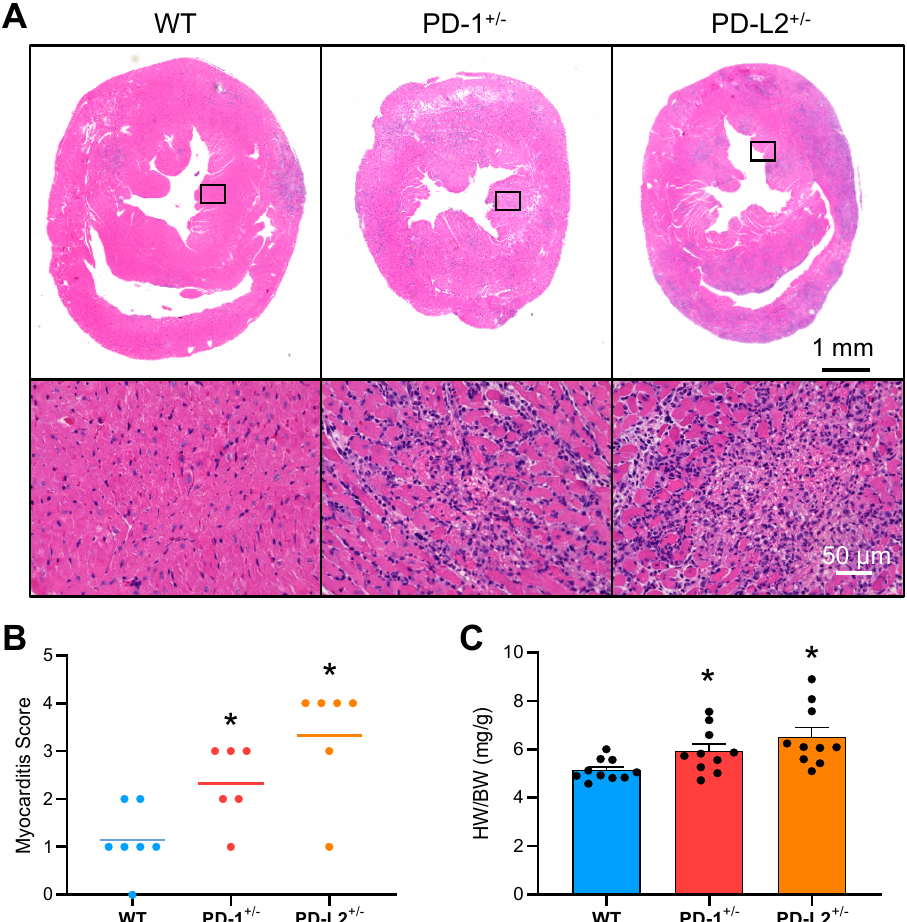
Figure 3. PD-L2 deficiency exacerbates myocardial inflammation in experimental autoimmune myocarditis. F1 hybrids of PD-1 − / − , PD-L2 − / − , and wild-type (WT) mice on the C57BL/6J background and BALB/c mice (PD-1 +/ − , PD-L2 +/ − , and WT, respectively) were immunized twice, on days 0 and 7, with cardiac myosin epitope peptide. ( A ) Representative H&E-stained sections of the hearts on day 14. Scale bars, 1 mm or 50 µ m. ( B ) Myocarditis severity in heart sections (n = 6–7 per group). ( C ) Heart-to-body weight ratios (HW/BW) of the mice (n = 10 per group). Results are presented as the mean ± standard error of the mean. * P < 0.05 vs. WT.